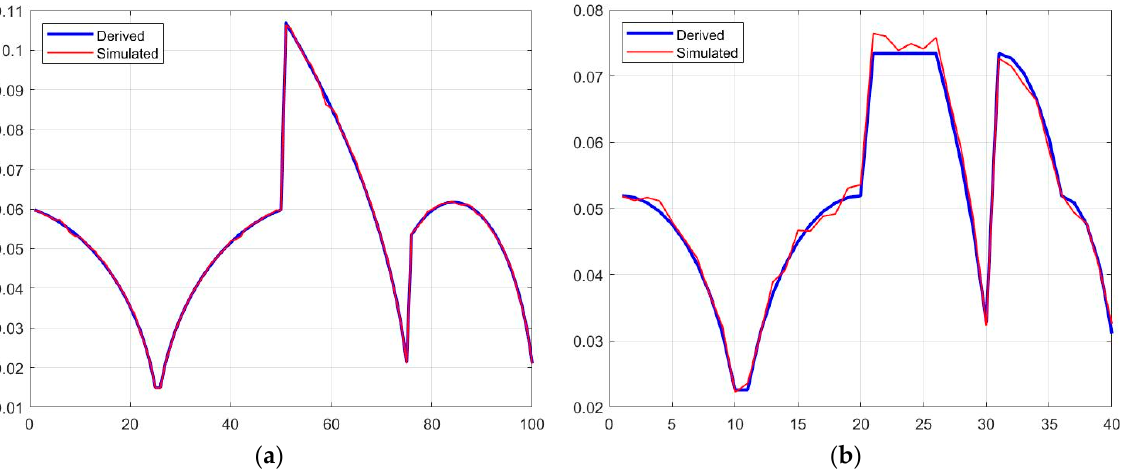
Figure A1. Comparisons between MDE values from theoretical derivations and Monte Carlo simulations. ( a ) B1C signal; ( b ) B2a signal.